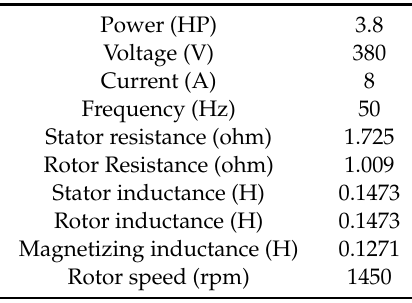
Table A1. Parameters and data specifications of the induction